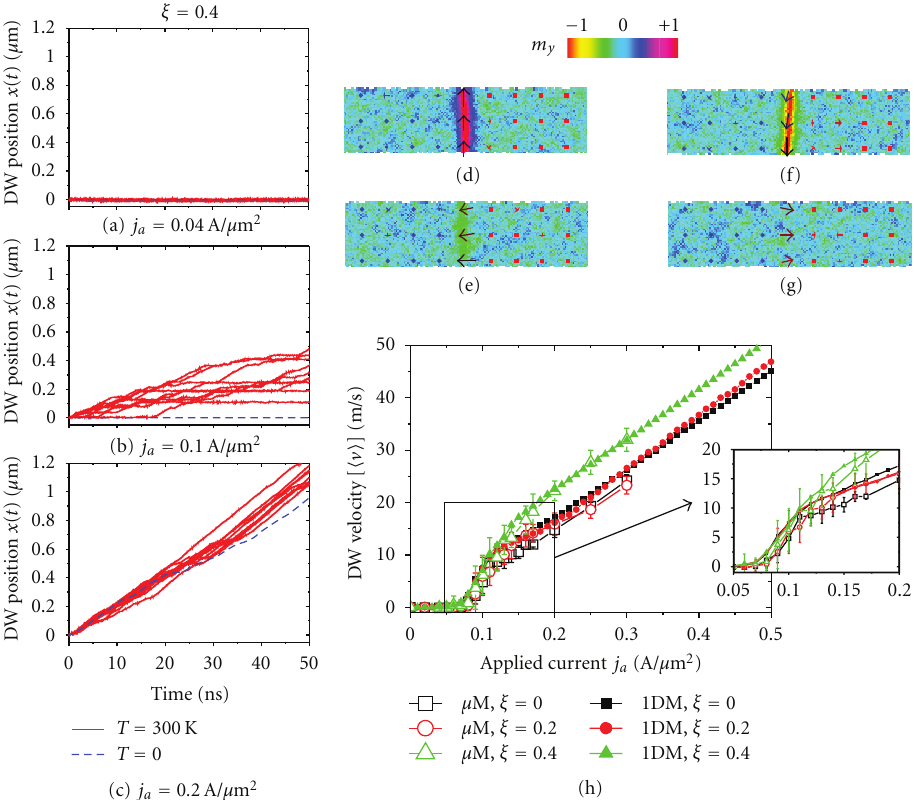
Figure 3: Current driven DW dynamics along a rough ( D g = 3nm) strip with L y × L z = 120 × 3nm 2 . Micromagnetically ( μM ) computed temporal evolution of the DW position x under three di ff erent density currents: (a) j a = 0 . 04A /μ m 2 , (b) j a = 0 . 1A /μ m 2 and (c) j a = 0 . 2A /μ m 2 for a nonadiabatic parameter of ξ = 0 . 4. Blue-dashed lines correspond to the deterministic case ( T = 0), whereas red-solid lines correspond to ten stochastic realizations at room temperature ( T = 300K). (d)–(g) show typical micromagnetic states of the propagating DW along a rough strip at room temperature. (h) Time-averaged DW velocity as function of j a for three di ff erent values of the nonadiabatic parameter: ξ = 0, ξ = 0 . 2, and ξ = 0 . 4. Open-dots correspond to μM results (with indication of the standard deviation), whereas solid symbols are the predictions from the 1DM with Δ = 8 . 325nm, H K = 12533 . 5A / m, and a periodic pinning potential given by V pin ( X ) = V 0 sin 2 ( πX/p ) with V 0 = 1 . 65 × 10 − 20 J and p = 30nm. The inset shows the results around between j a = 0 . 05A /μ m 2 and j a = 0 . 2A /μ m 2 (Reprinted with permission From [70]. Copyright (2012), American Institute of